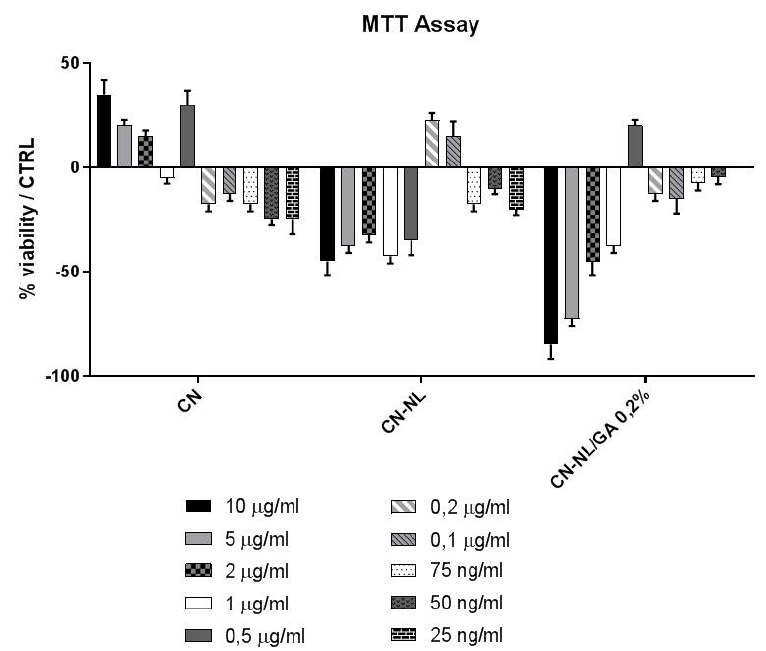
Figure 6. Results of MTT assay for different concentrations of CN, CN-NL, CN-NL/GA (0.2%), using HaCaT cells. The results were normalized by the viability of untreated cells as control.